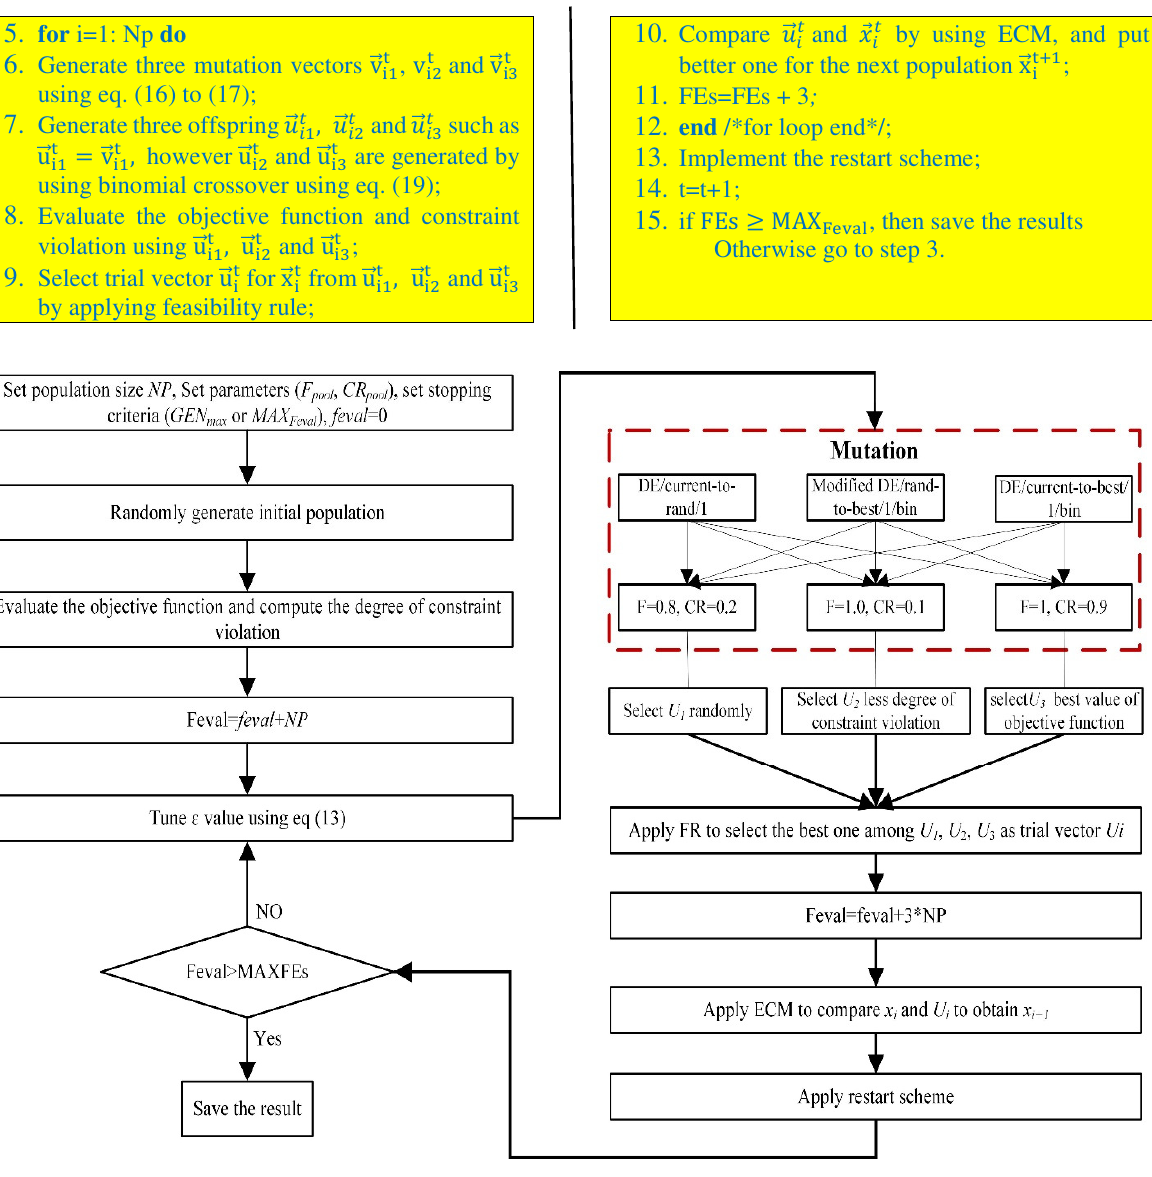
Fig. 4: Flowchart for the implementation of C 2